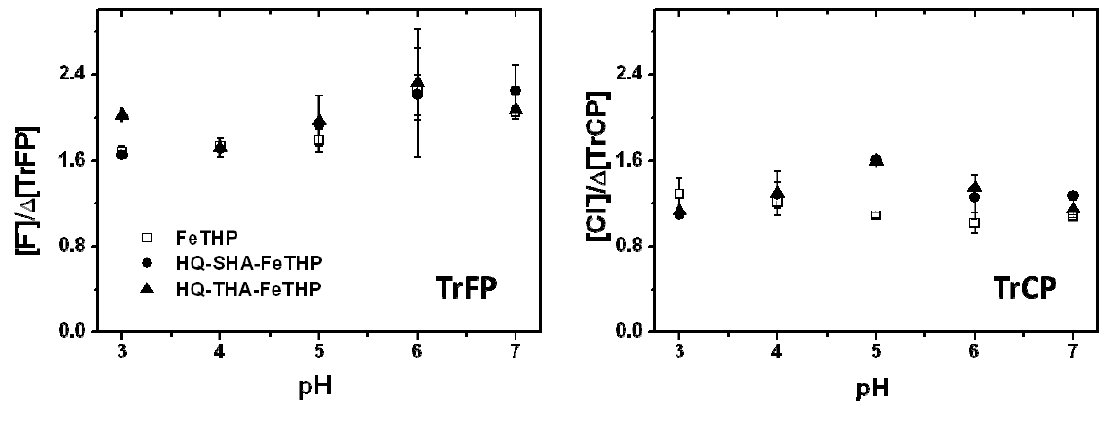
Figure 3. Influence of pH on the number of F − , Cl − , Br − and I − released as a result of